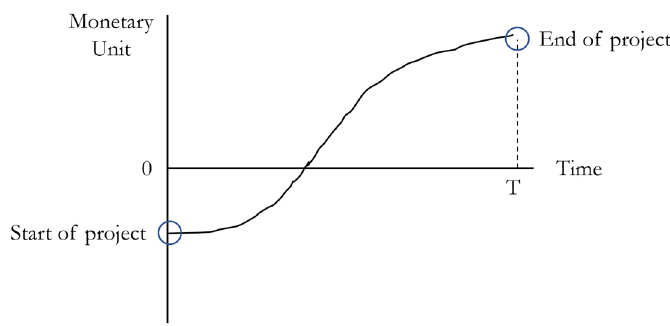
Figure 3. Typical time-stream of project net benefits.